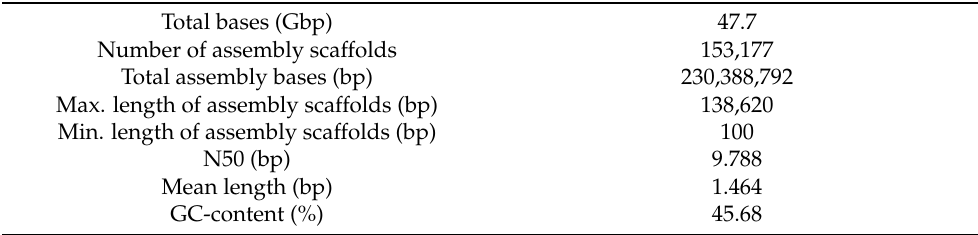
Table 1. The statistics of assembly of flow-sorted short arm of H. villosa 6V chromosome.